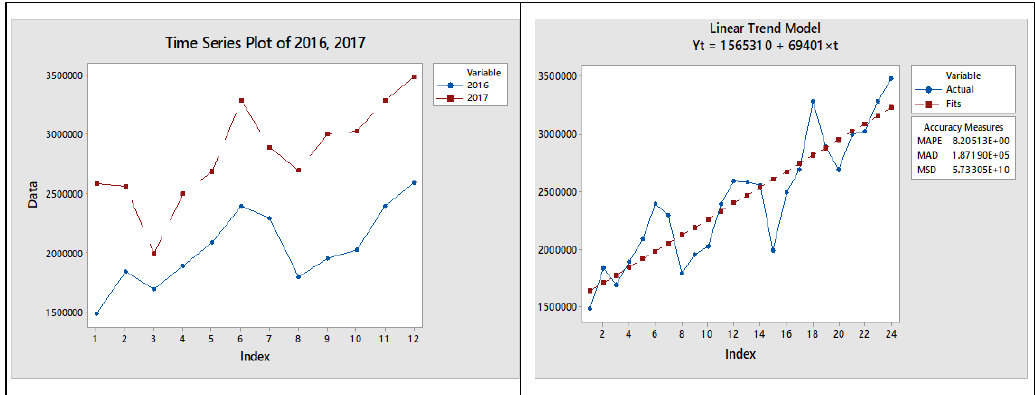
Fig. 4. Seasonal pattern and trend analysis for